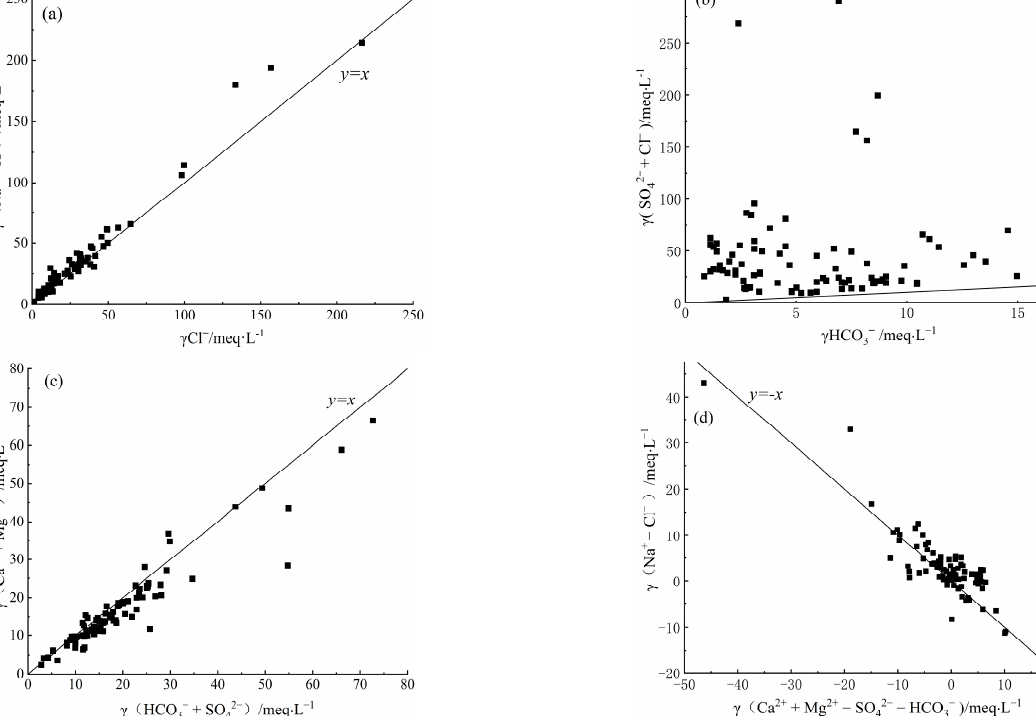
Figure 8. Groundwater ion ratio diagram. ( a ) Scatter plot of γ (Na + + K + ) versus γ Cl − ; ( b ) Scatter plot of γ (SO 42 − + Cl − ) versus γ HCO 3 − ; ( c ) Scatter plot of γ (Ca 2+ + Mg 2+ ) versus γ (HCO 3 − + SO 42 − ); ( d ) Scatter plot of γ (Na + − Cl − ) versus γ (Ca 2+ + Mg 2+ − HCO 3 − + SO 42 − ).